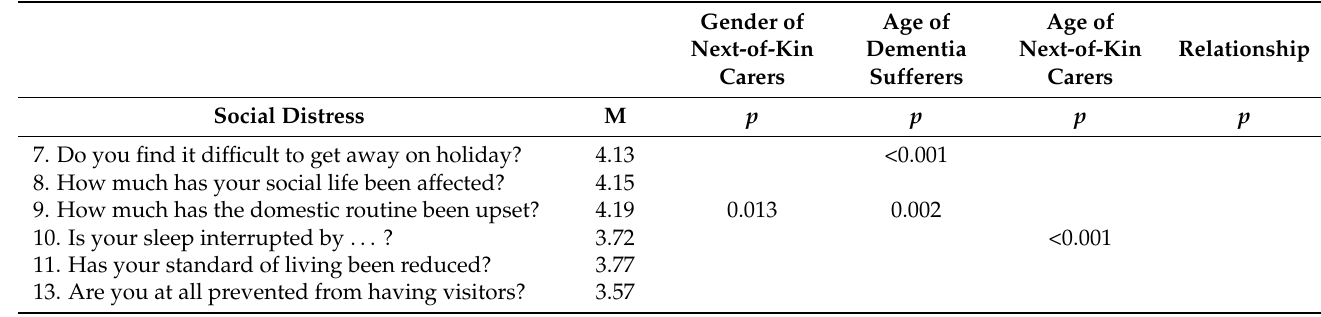
Table 3. Differences in the RSS assessment based on selected factors.